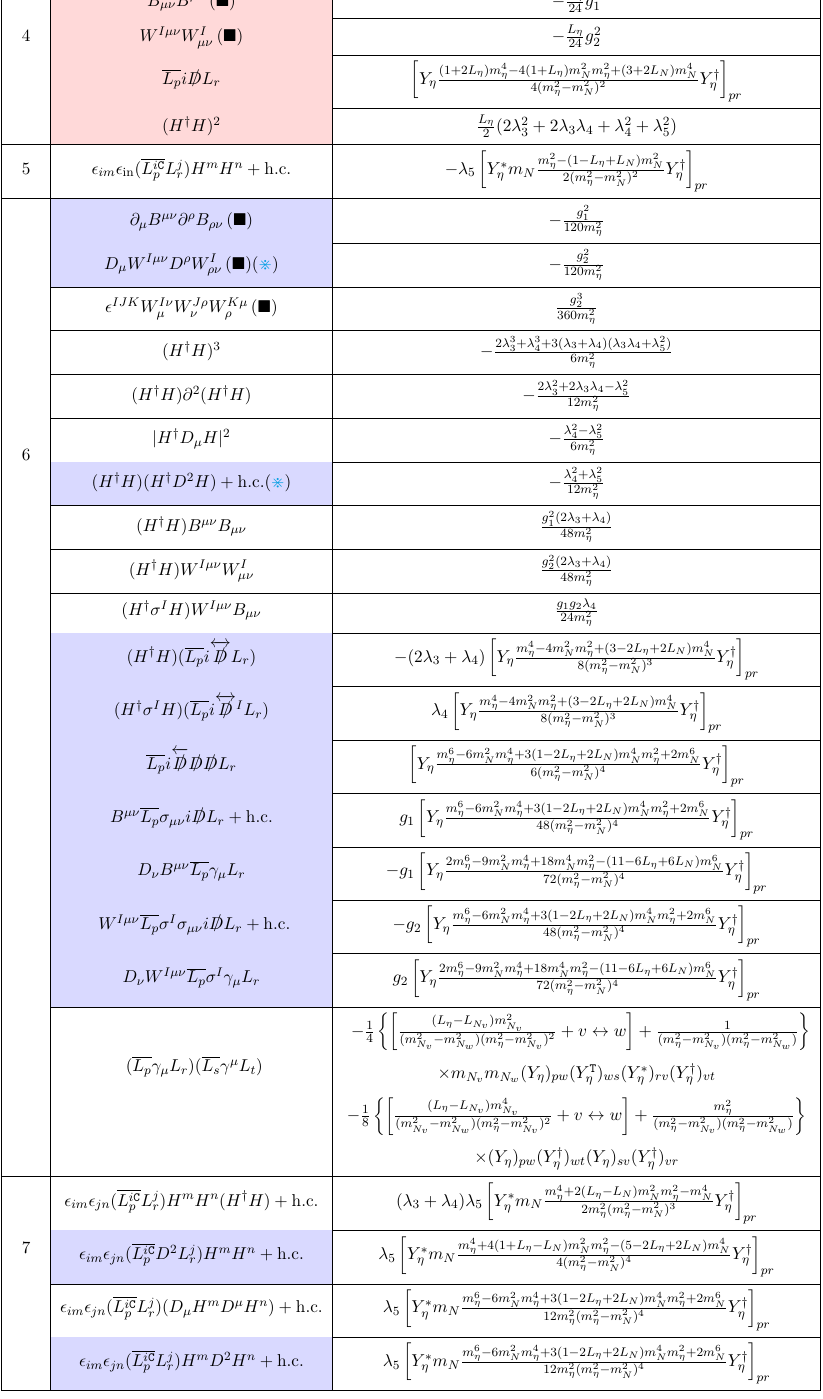
Table 1 . The one-loop matching result for the scotogenic model in the heavy N and η case in a Green basis. The pink sector contributes to the threshold correction, while the blue sector will be reduced by using EoMs. See the text for the notations (cid:4) and >